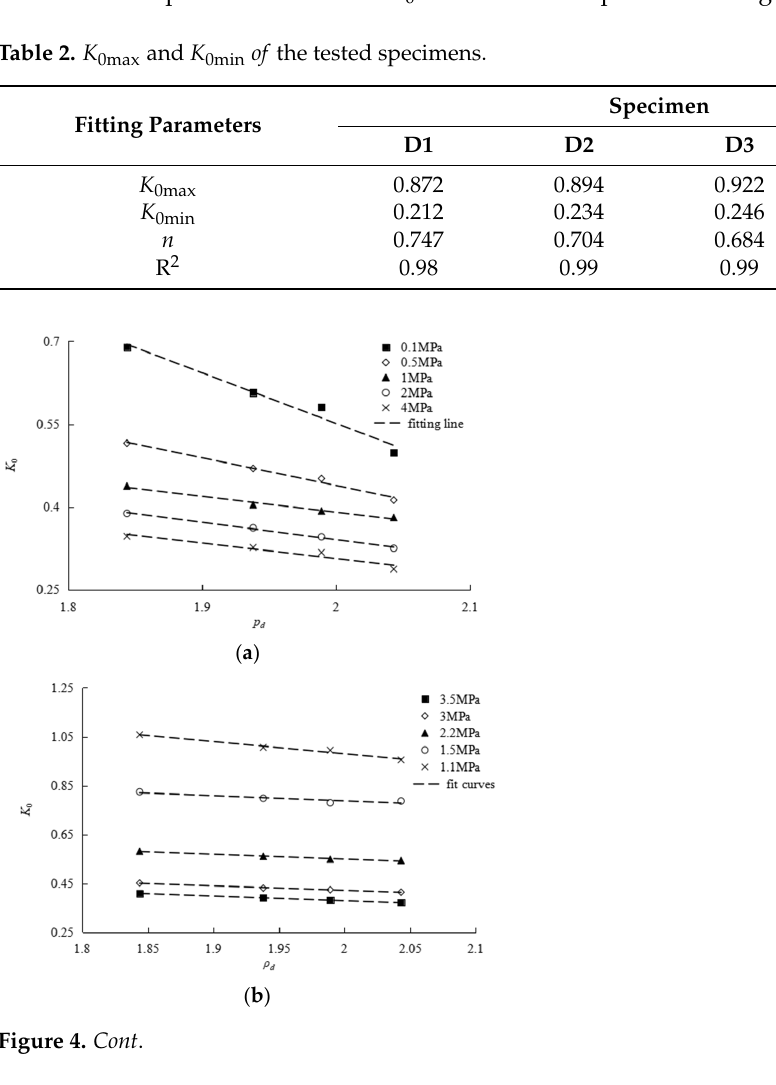
( c ) Figure 4. K 0max / K 0min – p d fi tt ing curves: ( a ) loading stage; ( b ) unloading stage. ( c ) K 0max / K 0min – D r 0 fi tt ing curves. Table 2. K 0max and K 0min of the tested specimens. Fitting Parameters